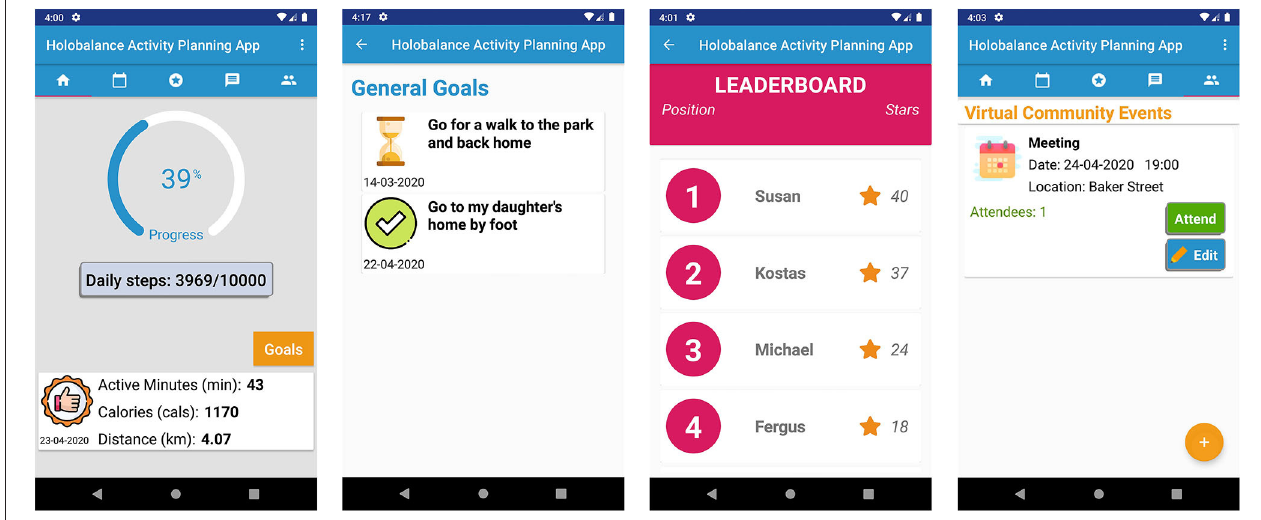
FIGURE 5 | Final version of the Activity Planning